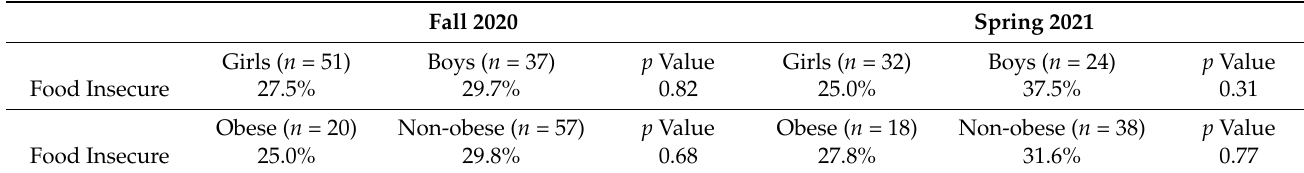
Table 3. Food security status by sex and obese weight status.